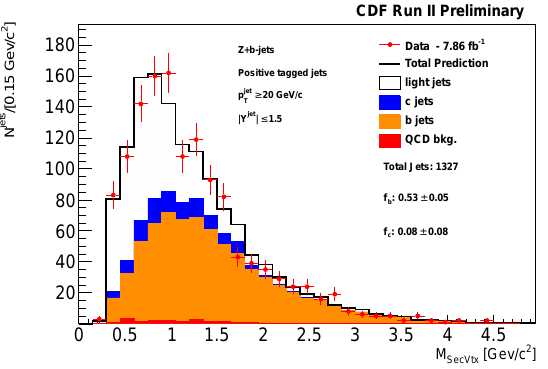
ℓ + ℓ − → Fig. 7. Normalised di ff erential cross section of Z + b -jet events as function of jet transverse momentum (top) and as function of jet rapidity (bottom). Comparison is made to MCFM NLO predic- tions with and without non-perturbative corrections